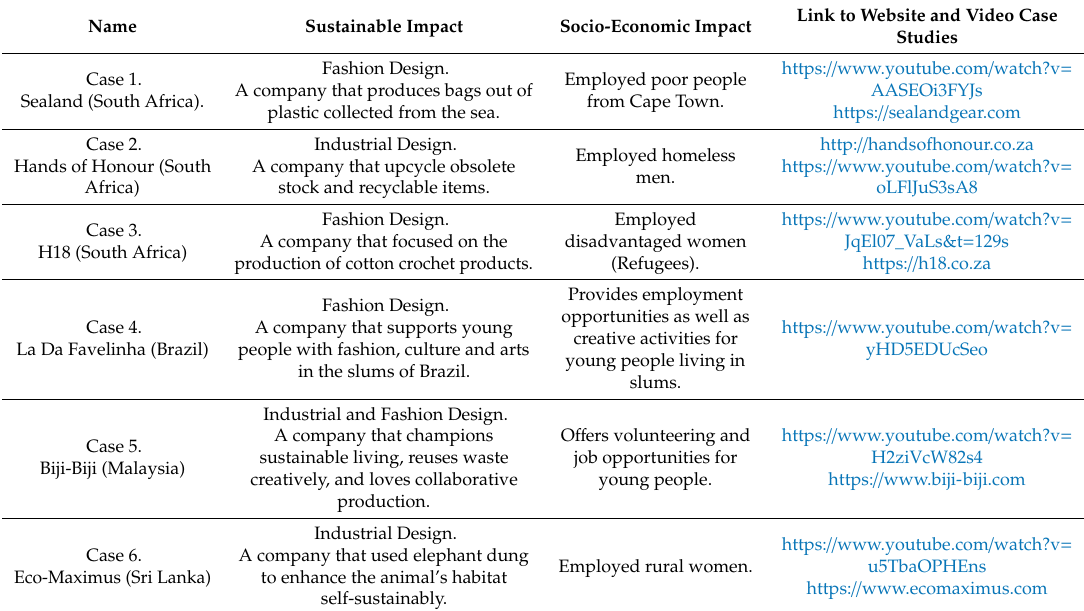
Table 3. Characteristics of grassroots